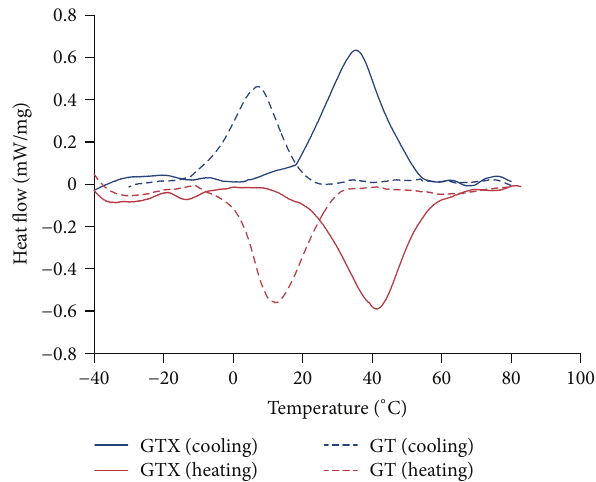
Figure 4: DSC curves for GT and GTX files obtained for cooling until − 40 ∘